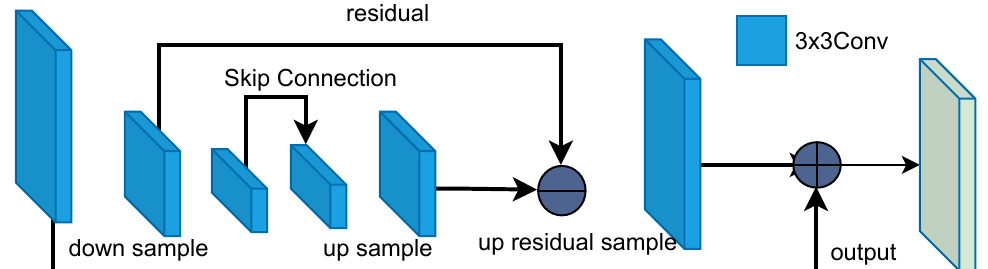
Figure 5. The FDBP for reconstruction in the